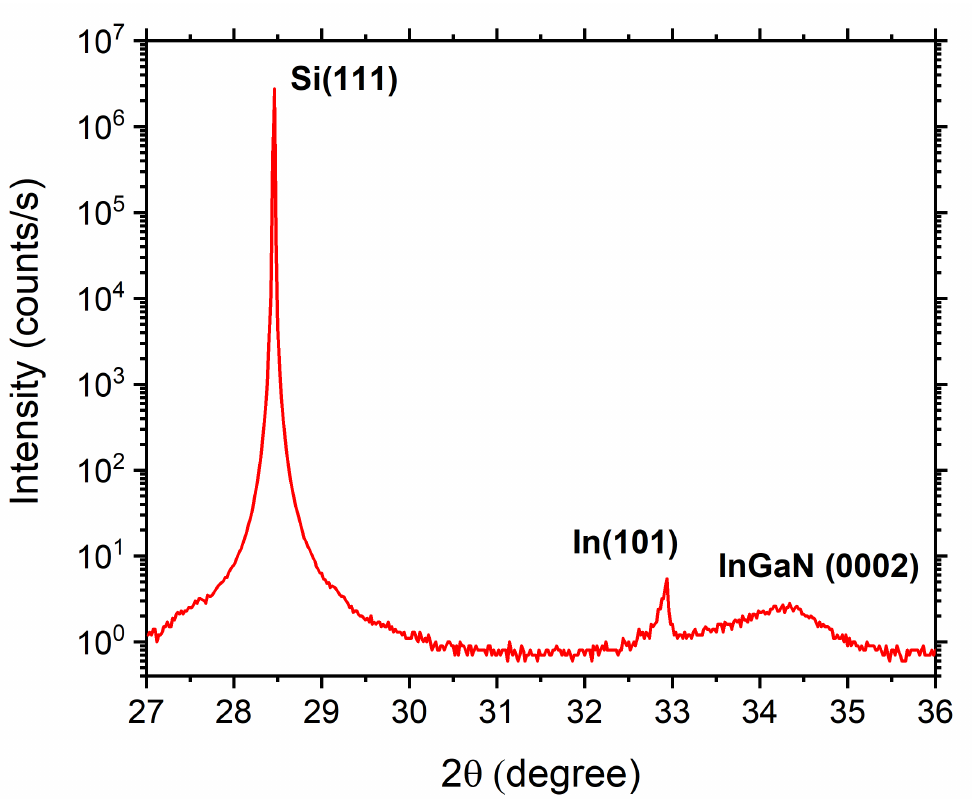
Figure 2. XRD ω − 2 θ scan in which it is possible to individuate the Si (111) peak at 2 θ = 28.5°, a sharp In (101) peak at 2 θ = 33° due to the diffraction of crystallized indium on the surface and the InGaN (0002) peak at 2 θ = 34.3°, which corresponds to an In concentration of